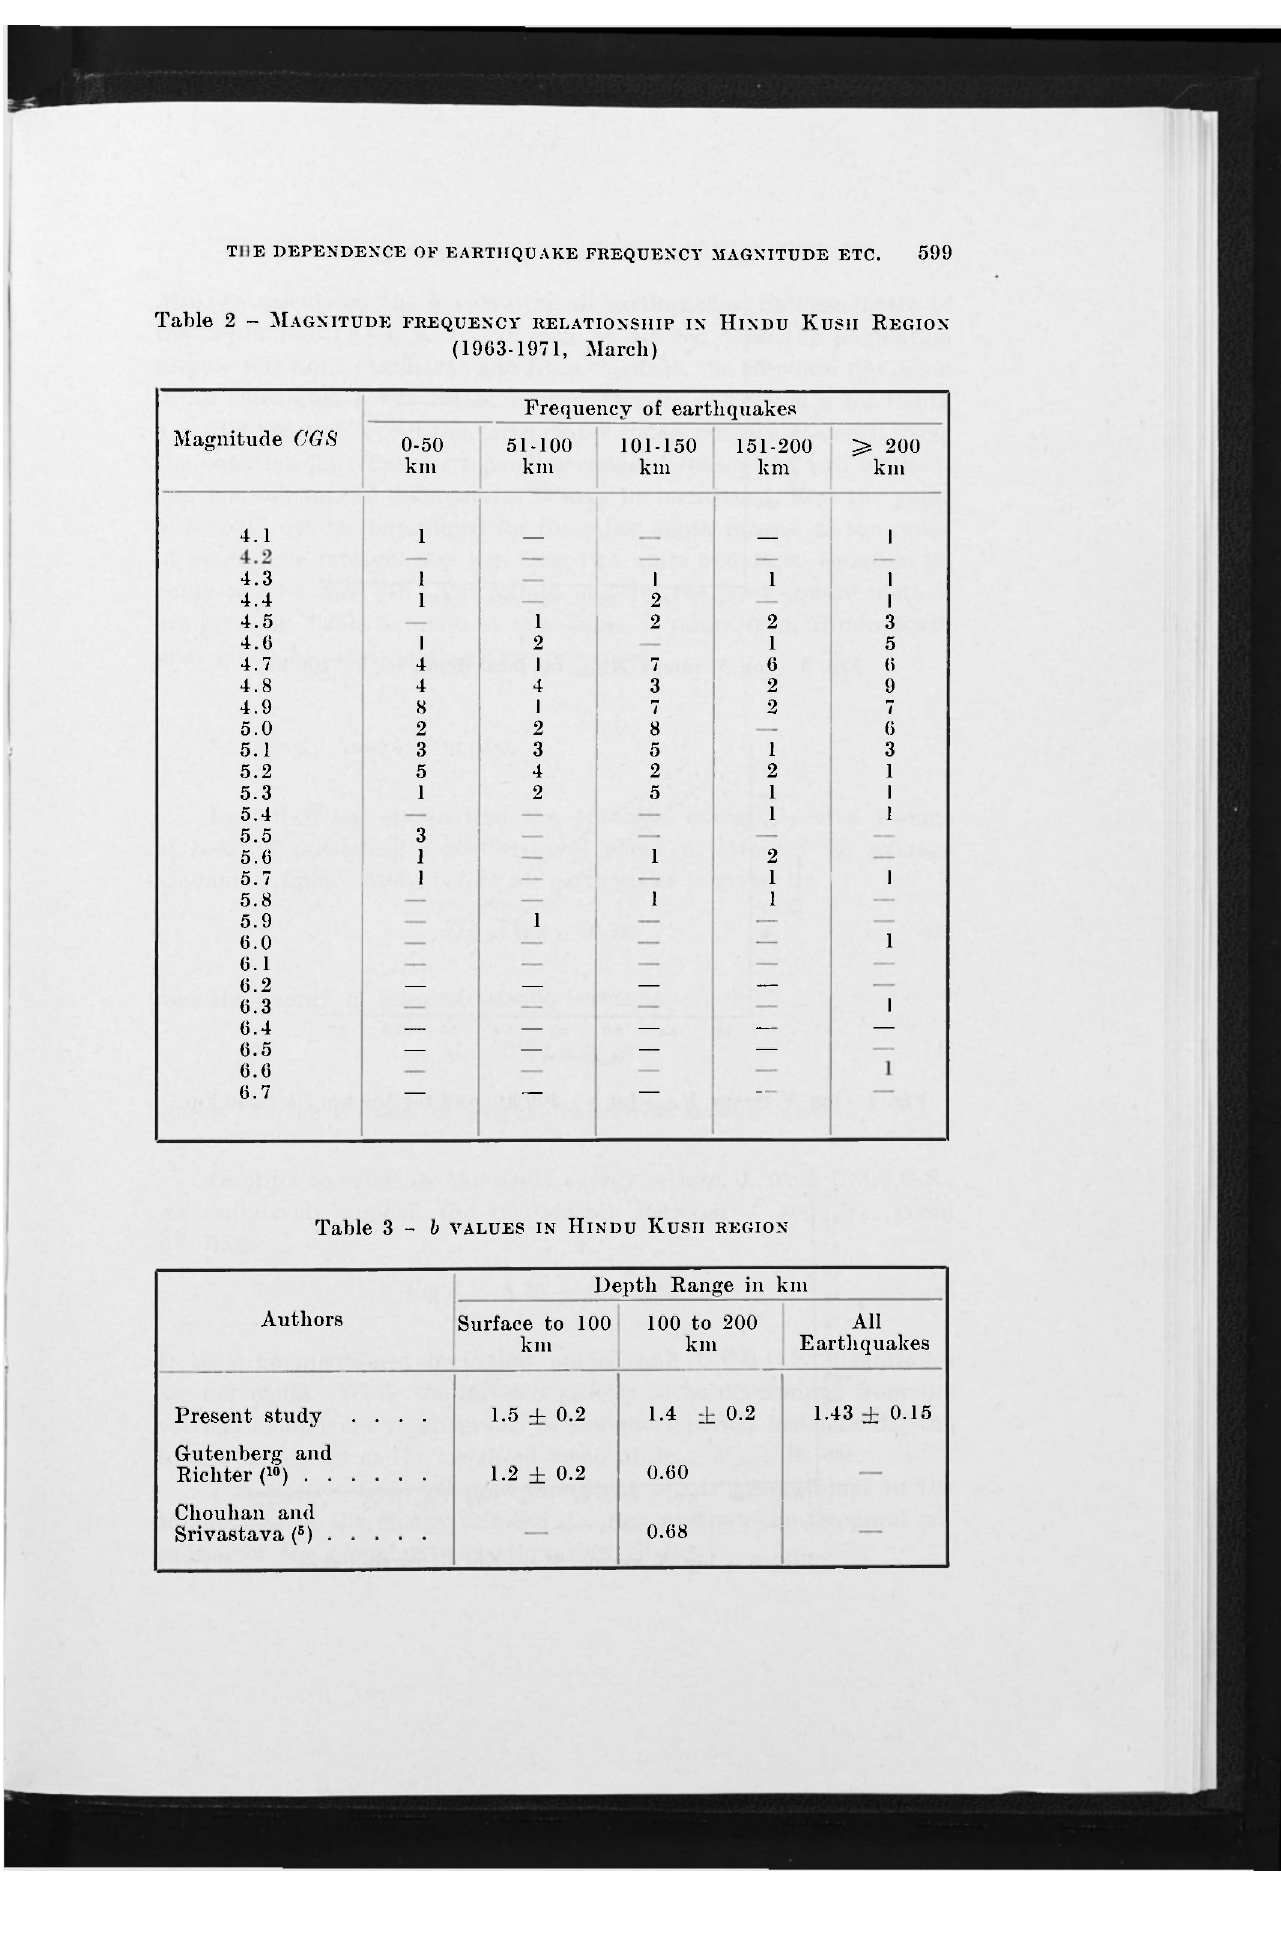
Table 2 - MAGNITUDE FREQUENCY RELATIONSHIP IN HINDU KUSII REGION